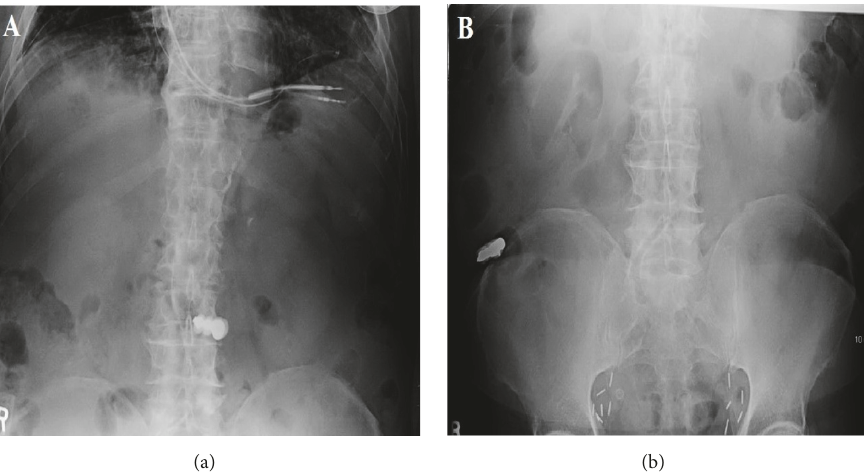
Figure 1: (a) The first abdominal radiograph demonstrating the dental plate in the mid abdomen. (b) The second abdominal radiography demonstrating the dental plate in the right lower quadrant and likely in the cecum.